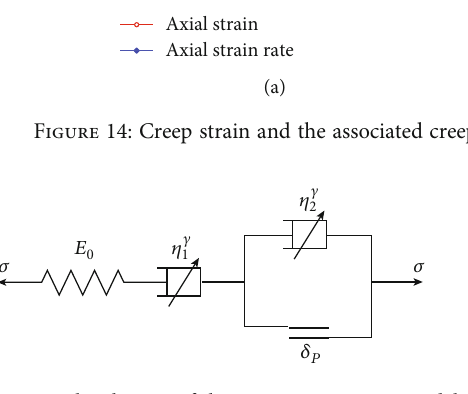
Figure 15: Sketch map of the creep constitutive